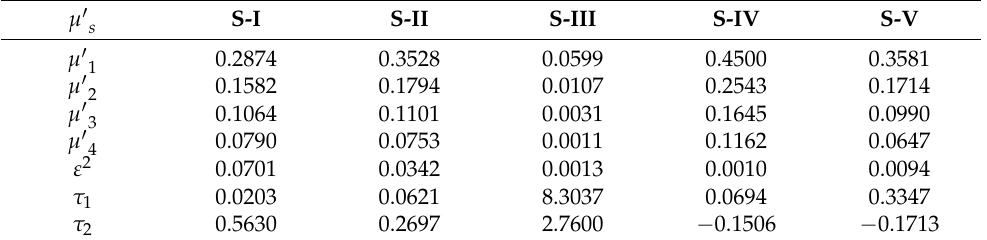
Table 2. Some numerical results of moments, variance ( ε 2 ), skewness ( τ 1 ), and kurtosis ( τ 2